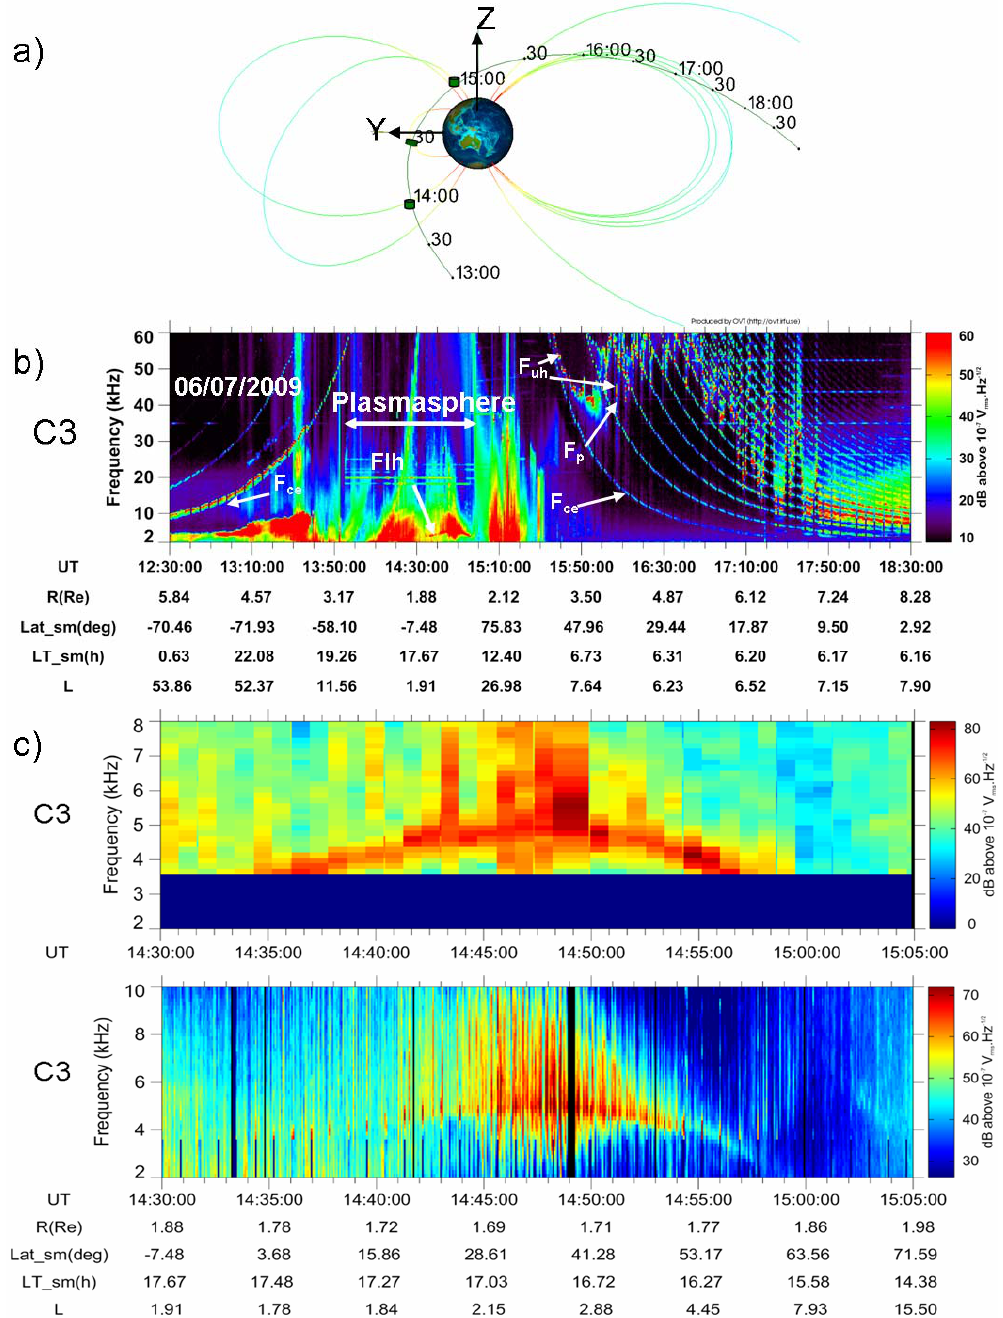
Fig. 2. Crossing of the plasmasphere typical of the late mission phase, here on 6 July 2009. (a) orbit of the C3 satellite and field lines in a GSM coordinate system with view from − X, produced by the OVT tool. (b) WHISPER spectrogram of combined active and passive spectra. C3 crosses the plasmasphere successively in the dusk and dawn sectors, under different conditions of altitude and L values. (c) Zoom of F lh observations near perigee. Top: spectrogram constructed from active spectra. Bottom: spectrogram combining active and passive observations.